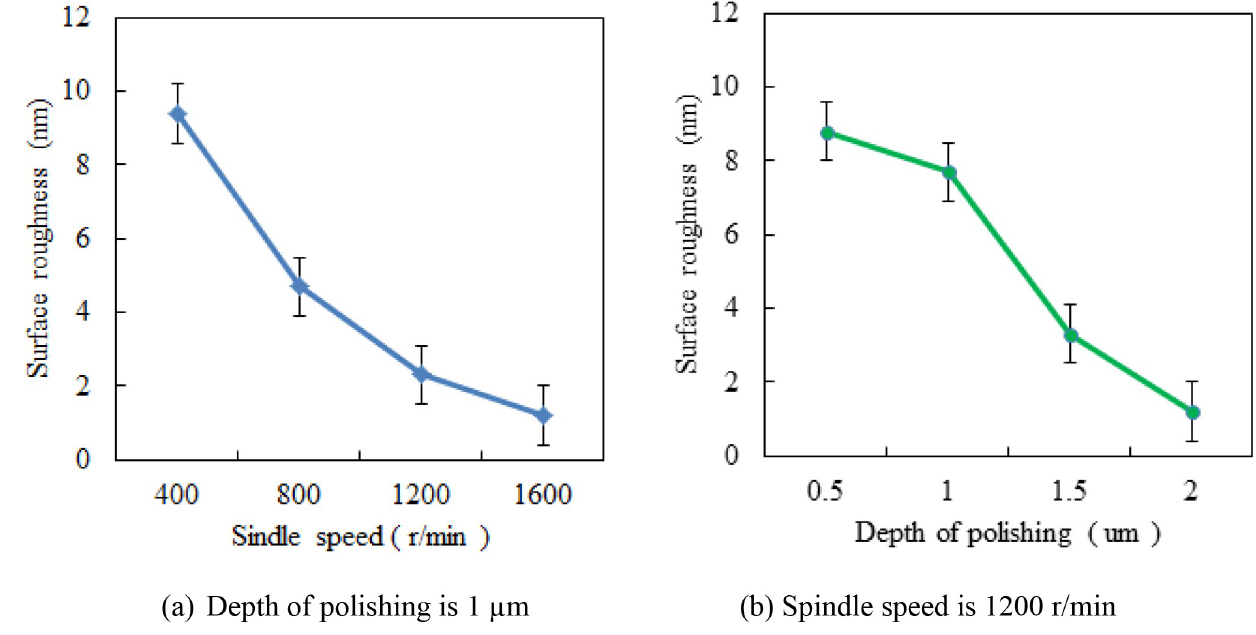
Fig 6. Influence of polishing depth and spindle speed on surface roughness.